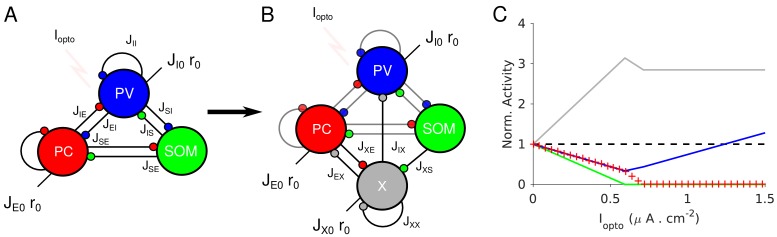
Network models with proportional change in the PC and PV activities upon photostimulation of the PV population.(A) A three-population network consisting of PCs, PV and SOM neurons. SOM neurons only receive projections from the PC and PV populations. (B) Model 2 consists of four populations: PC, PV, SOM and an unidentified inhibitory population, X. The population X projects to the PC, the PV population and to itself. The PC population projects to X. (C) Population activities normalized to baseline vs. Iopto in the large N, K limit. PC and PV populations decrease their activity with Iopto in a proportional manner. Parameters as in Tables 6–7. Baseline firing rates are: rE = 3.0 Hz, rI = 6.7 Hz, rS = 6.4 Hz, rX = 3.8 Hz.